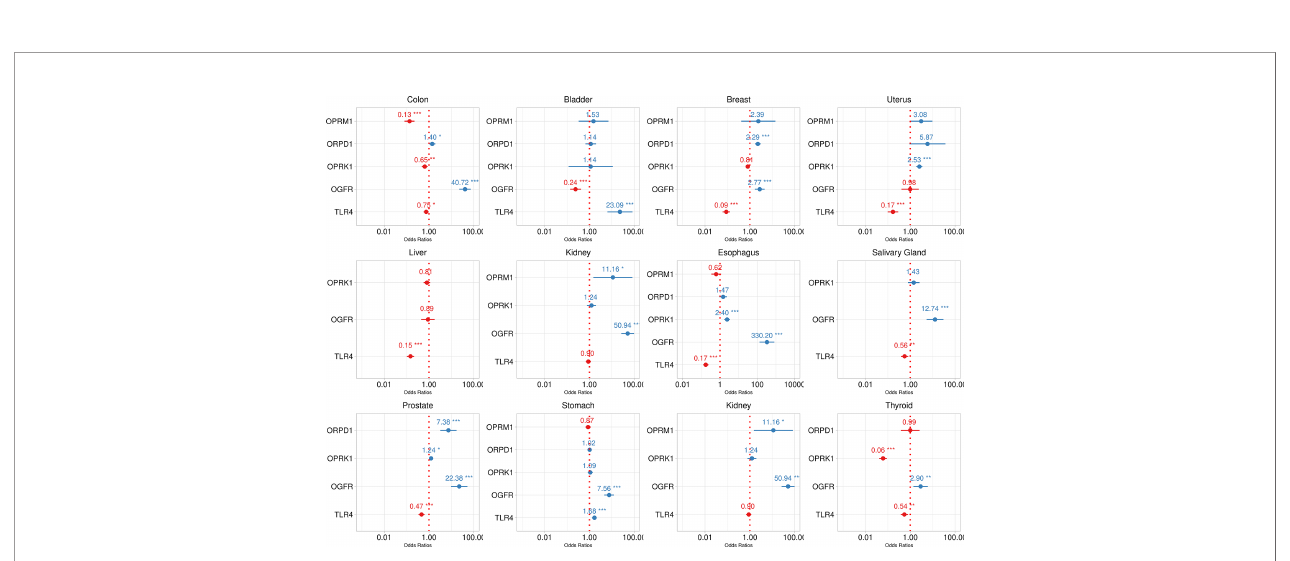
FIGURE 4 | Logistic model fi t of opioid receprotrs association with tumor tissue by tumor type. Dotted red line represents no effect. Estimates are reported as red or blue when the odds ratio point estimate is lower or greater than one respectively. Dots are point estimates and bars 95% con fi dence intervals. Statistical signi fi cance is reported as * < 0.05, ** < 0.001, *** <